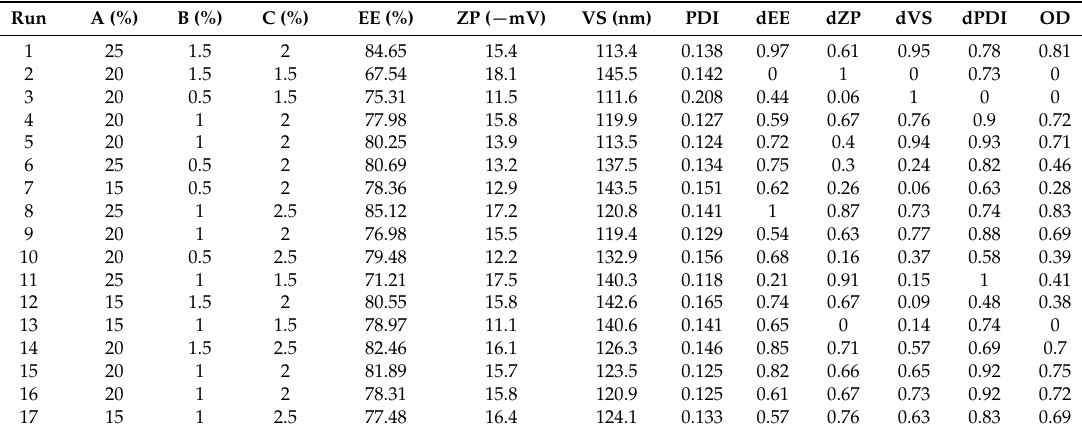
Table 3. Experimental design matrix and